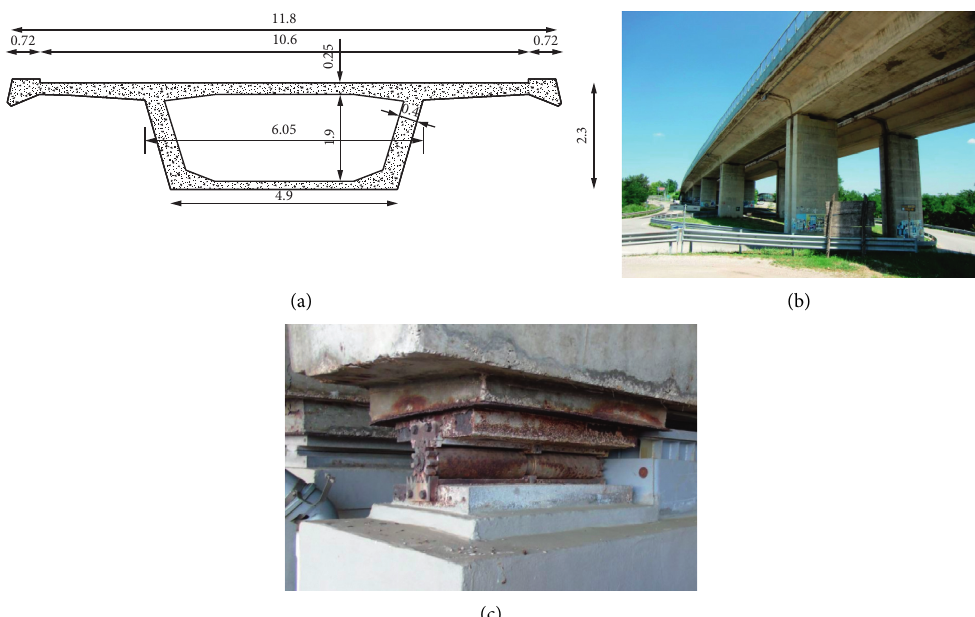
Figure 1: (a) Cross section of the bridge. (b) View of the Cretara viaduct of the A24 motorway. (c) View of the rack and roller